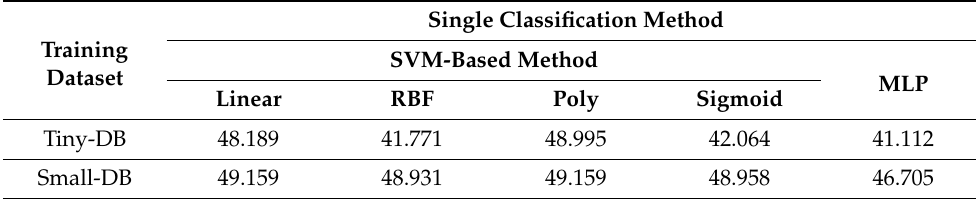
Table 9. Classification performance of SVM- and MLP-based methods using the BT-Large dataset according to the size of the training data (unit: %).